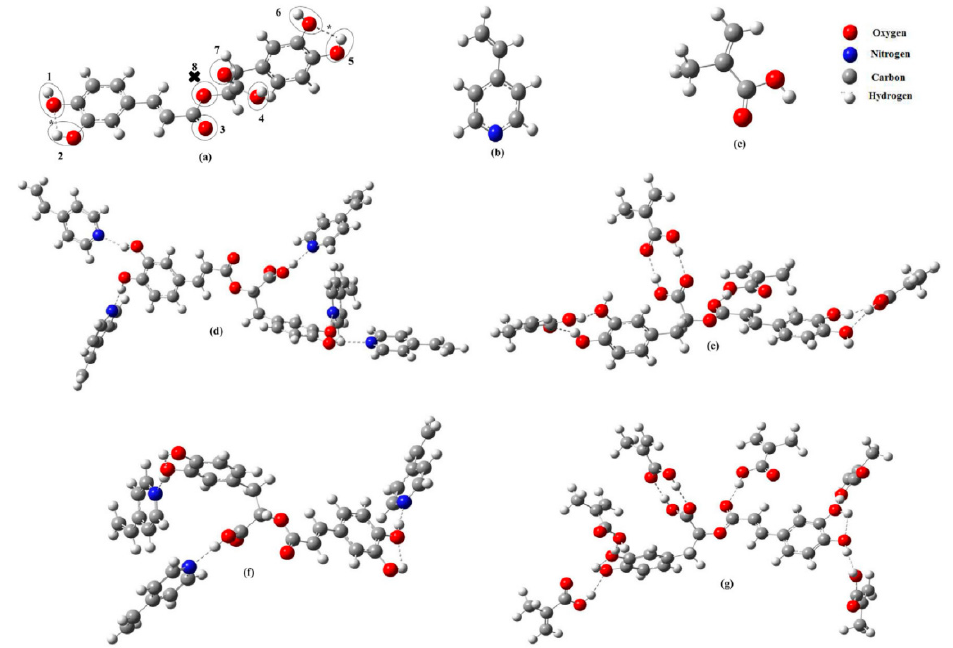
Figure 11. Computer optimized structures of ( a ) RA, ( b ) 4-VP, and ( c ) MAA, conformations, optimum. ( d ) RA-(4-VP) 5 and ( e ) RA-(MAA) 4 conformations assuming no intra-molecular H-bond formation, optimum ( f ) RA-(4-VP) 3 , and ( g ) RA-(MAA) 6 conformations assuming intra-molecular H-bond formation. The possible active binding sites are encircled, * represents possible intra-molecular H-bonds of a distance (2.166–2.174 Å), and x represents the site incapable of H-bonding with MAA. Reprinted with permission from Ref. [106]. Copyright (2021) Elsevier.